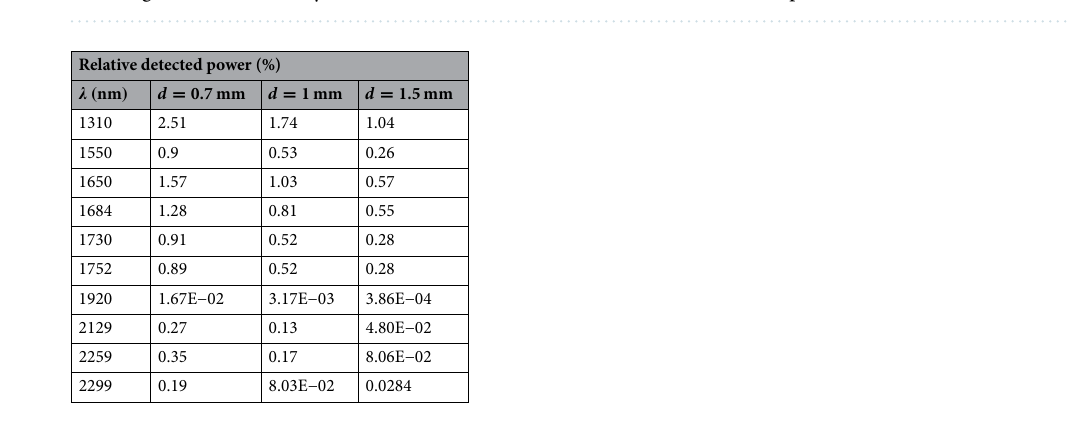
Figure 5. Absorbance spectra at SWIR optical wavelengths and lactate concentration. Variation in absorbance with the wavelength at (cid:31) = 1310 nm, 1550 nm, 1650 nm, 1684 nm, 1730 nm, 1752 nm, 1920 nm, 2259 nm and 2299 nm is demonstrated in ( a ), and the variation with the lactate concentration ( C lact = 1–6 mmol/L) are displayed as insets. For further illustration, the wavelength sets were divided into three categories, and the variations in the normalized absorbances with lactate concentration are shown in ( b.1 ) lactate peak wavelengths, ( b.2 ) water peak wavelength, and ( b.3 ) non-peak wavelengths. Absorbance at lactate-peak wavelengths exhibit non-linearity among the wavelengths. The water peak-wavelength exhibits random results and the non-peak wavelengths exhibit linearity. Simulations were carried out at a source-detector separation of 1 mm.